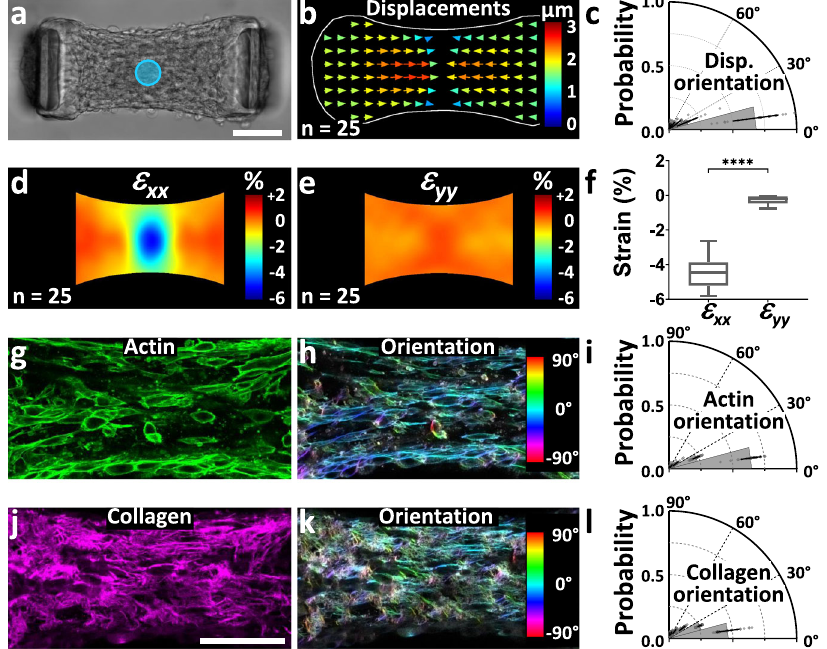
Fig. 2 | The anisotropy of the optogenetically-induced contraction correlates with the microtissue architecture. a Representative microtissue where the blue disc represents the 50 µ m diameter isotropic stimulation area. b Resulting average displacement fi eld(forreadabilityreasons,onlyhalfofthevectorsarerepresented) and c polar plot of its orientation. Data are presented as mean±SD with n =25 microtissues over 2 independent experiments superimposed with a dotplot ofthe data distribution. Resulting average strain fi elds ( ε xx in d , ε yy in e ) and comparison oftheaveragestrainamplitudesintheareaofstimulation( f ).Dataarepresentedas Tukeyboxplots(i.e.theboxextendsfromthe25thto75thpercentiles,themedian isplottedasalineinsidetheboxandthewhiskersextendtothemostextremedata point that is no more than 1.5 times the interquartile range from the edge of the